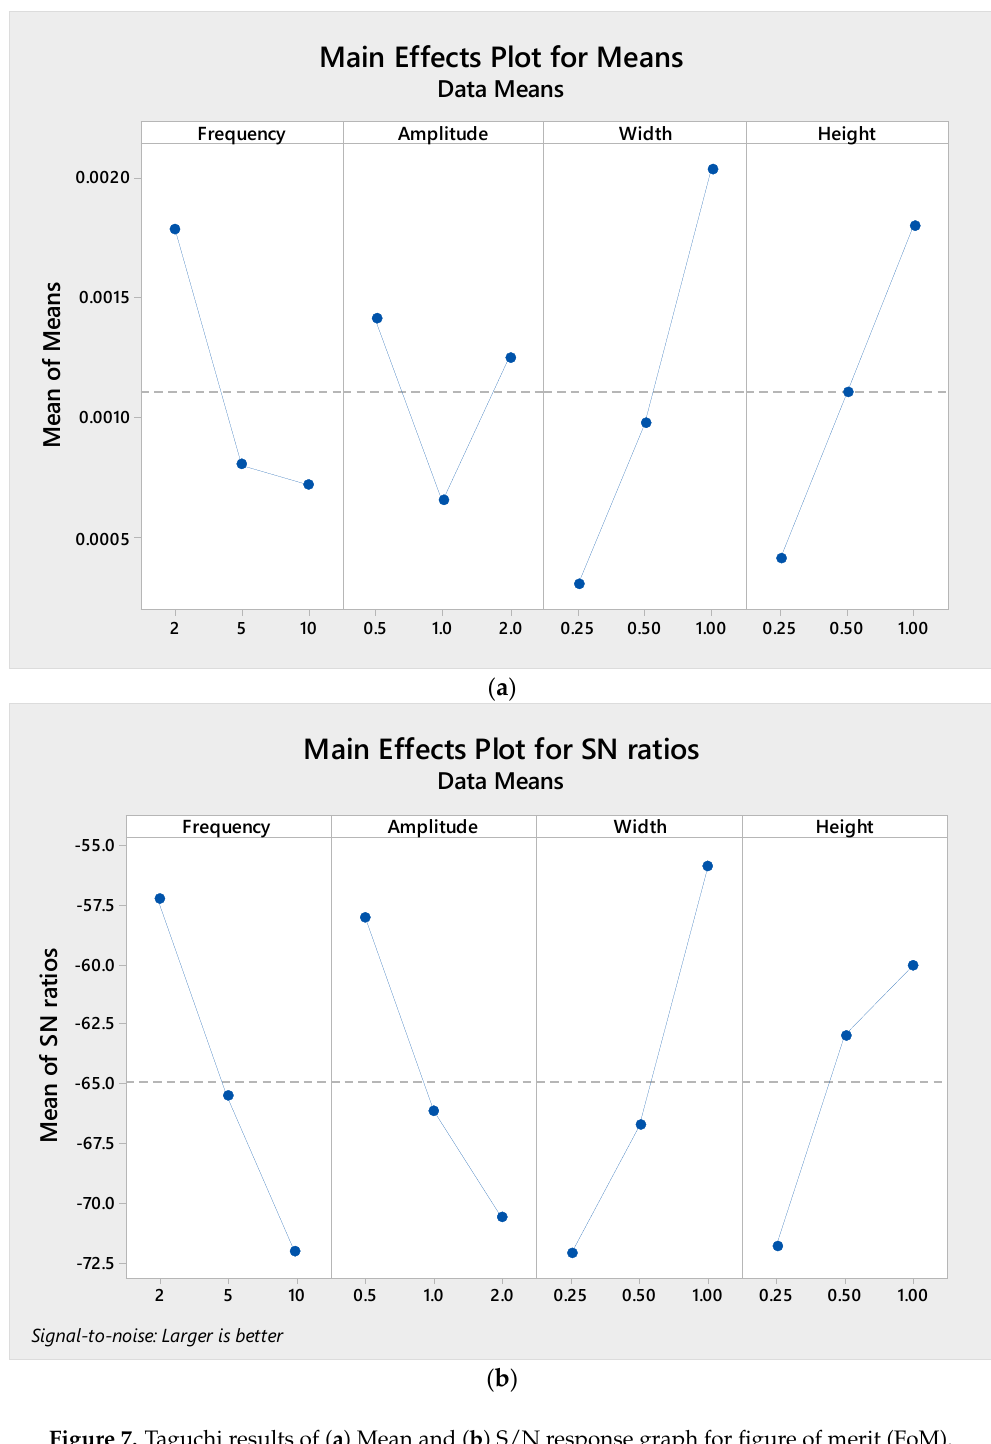
Figure 7. Taguchi results of ( a ) Mean and ( b ) S/N response graph for figure of merit (FoM).